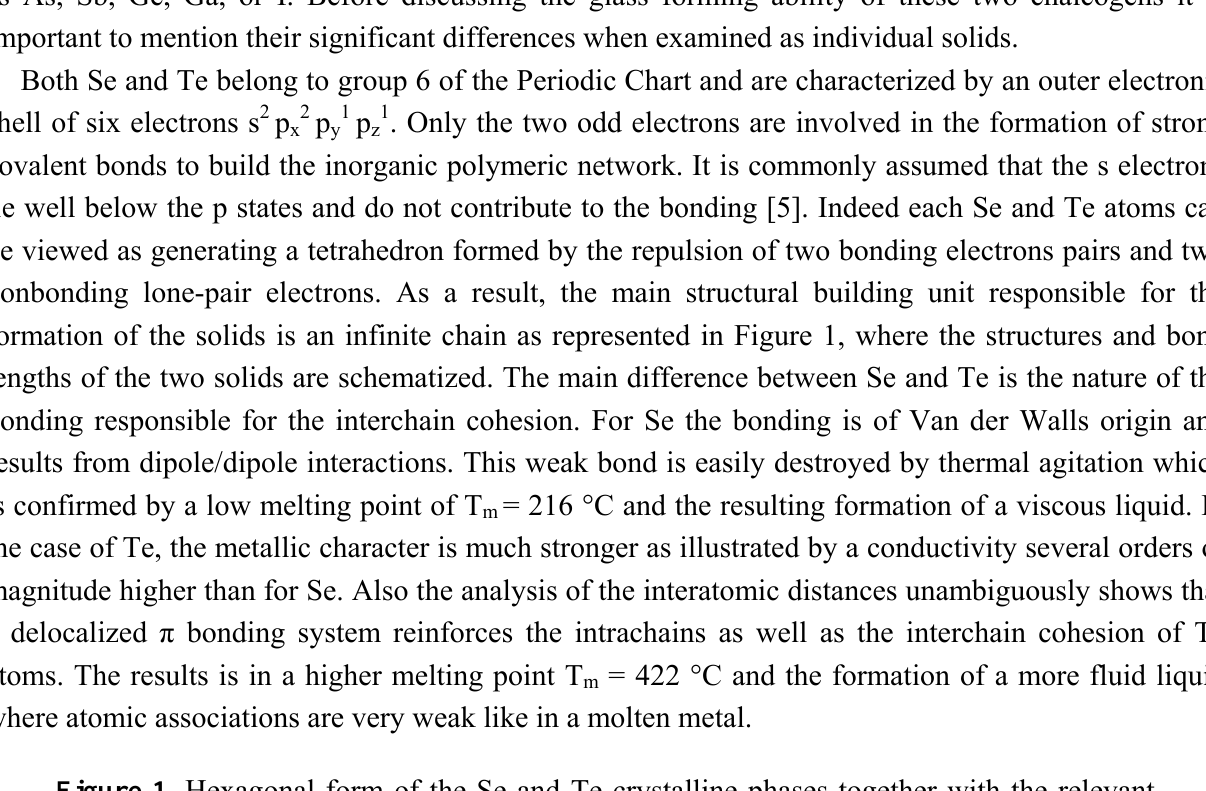
Figure 1. Hexagonal form of the Se and Te crystalline phases together with the relevant distances representatives of their opposite physical behaviors (see text)